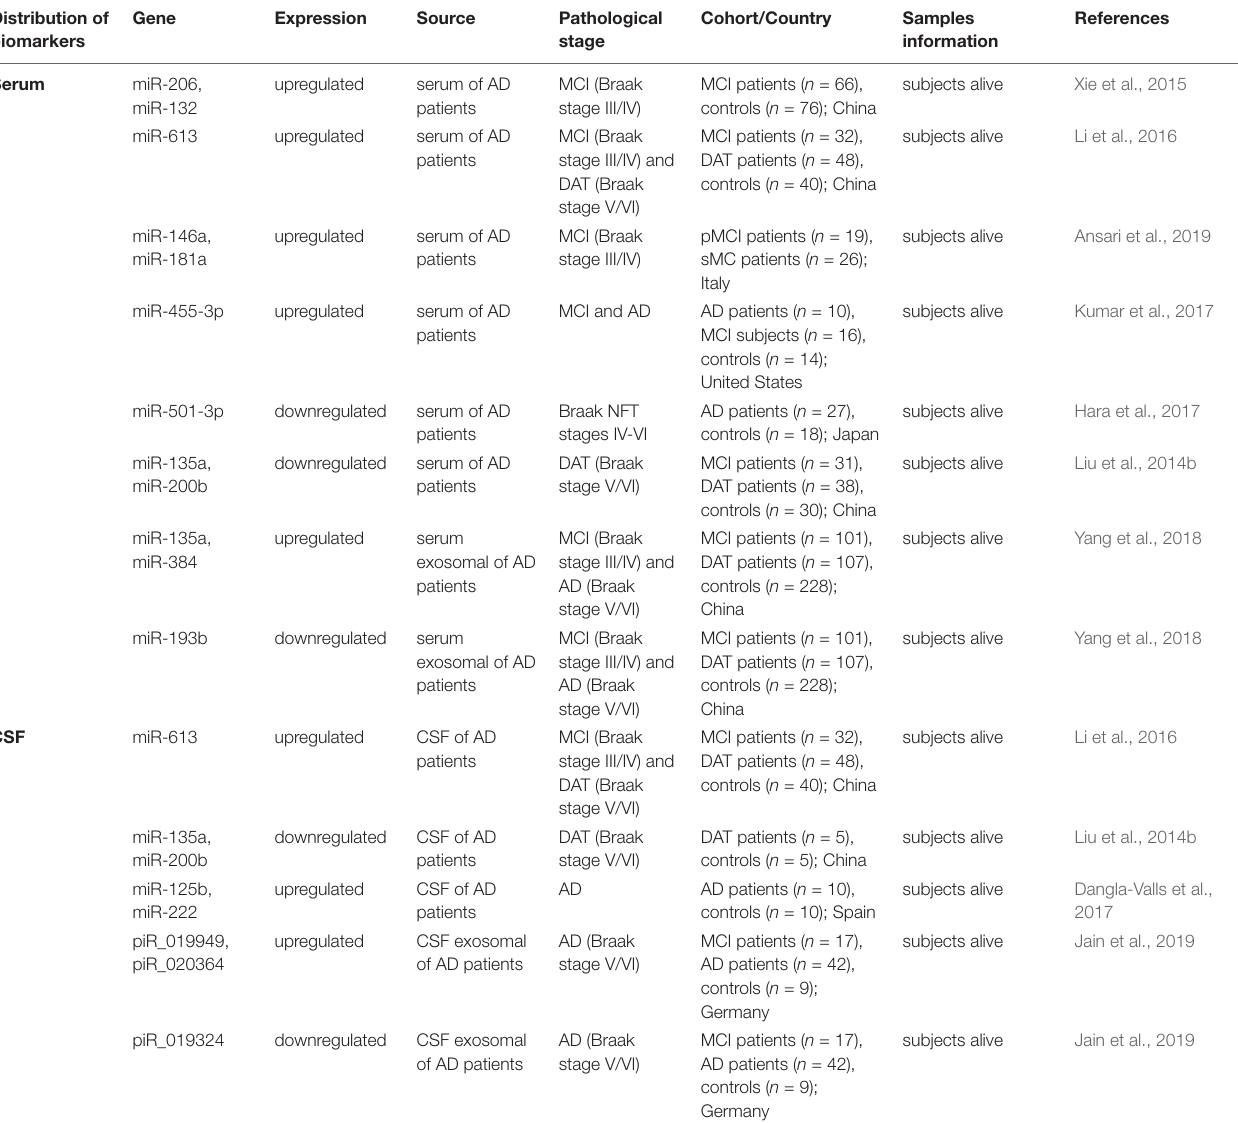
TABLE 3 | Summary of ncRNAs as biomarkers for AD. Distribution of